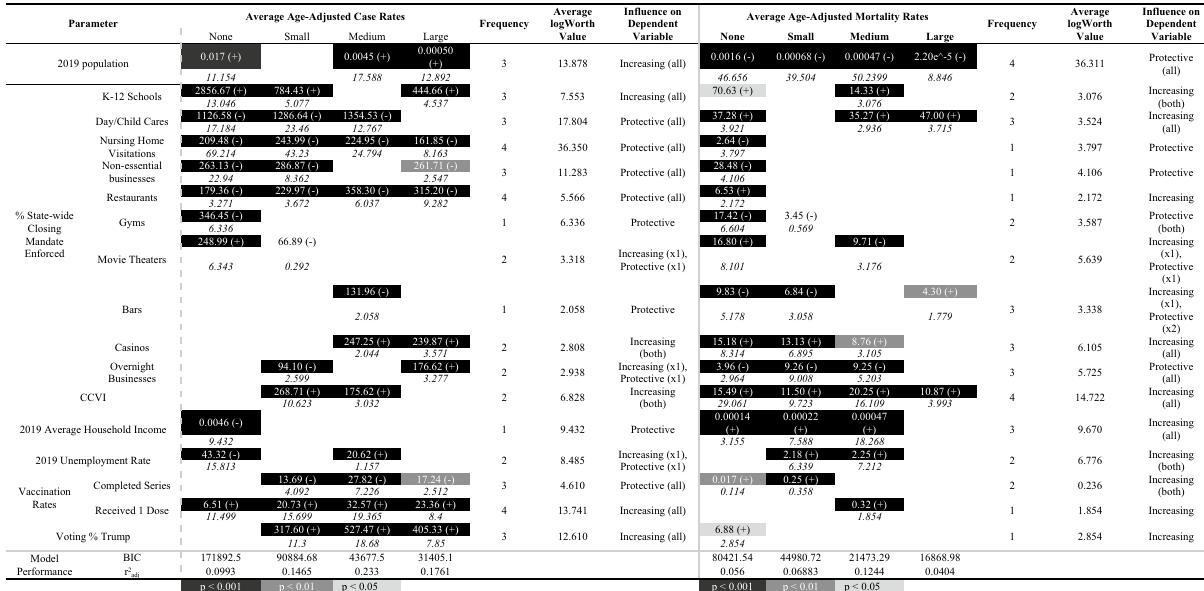
Table 2. Matrix displaying covariates (n = 18) included in each final model (Aim 1) assessing age-adjusted case (A) and mortality (B) rates by university enrollment and race & ethnicity. Overall significance for each included covariate is indicated by gray shade (light gray = p < 0.05, dark gray = p < 0.01, black = p <